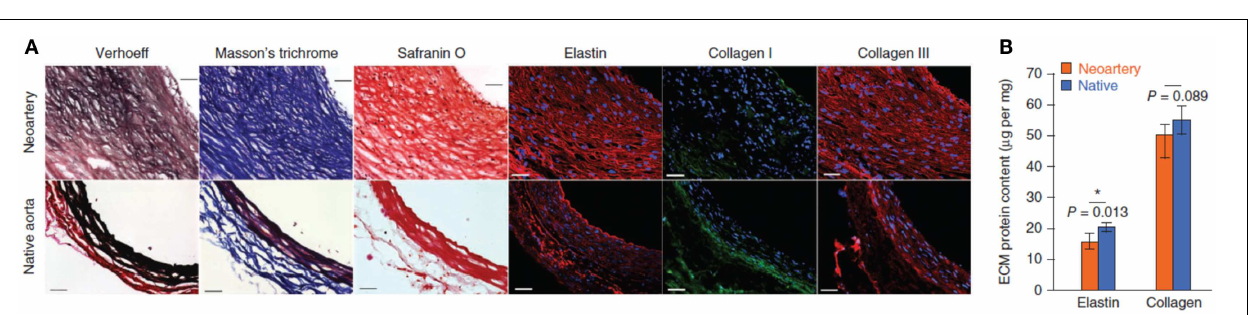
Top: day 90 explant; bottom: native aorta. Scale bars, 50 µ m. (B) Quantification of elastin ( n = 4) and total collagen ( n = 4). Data represent mean ± SD. Adapted by permission from Macmillan Publishers Ltd.: (Nature Medicine) (Wu et al., 2012), copyright